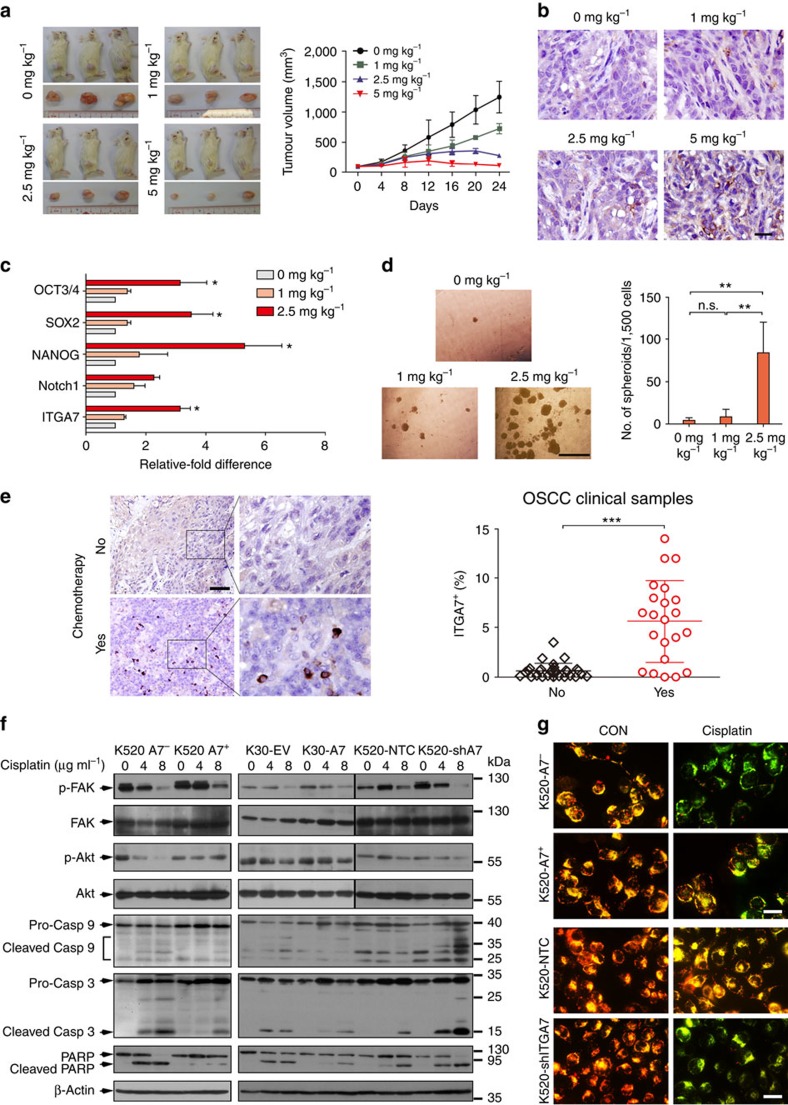
ITGA7 promotes chemoresistance via the FAK/Akt/Caspase-9/Caspase-3 pathway.(a) NOD/SCID mice with xenograft tumours of 5 mm in diameter were randomly separated into four groups and treated with varying doses of cisplatin. The doses of 2.5 and 5 mg kg−1 cisplatin could effectively suppress tumour growth and shrink tumour size. The average tumour volume was expressed as the mean±s.d. of three mice. (b) Representative IHC images showing that ITGA7+ cells were positively correlated with the dosage of cisplatin. Scale bar, 20 μm. (c) qRT-PCR showed that the expression of ITGA7 and stemness-associated genes was positively correlated with the dosage of cisplatin. (d) Representatives and summary of spheroid formation assay showing that isolated cells from chemoresistant group displayed enhanced self-renewal ability. Scale bar, 500 μm. (e) Representative images of ITGA7 IHC staining of clinical OSCC specimens had or had not undergone chemotherapy treatment. Compared with OSCC specimens without treatment (0.64%±0.74%; n=28), ITGA7+ cells were markedly increased after treatment (5.64%±4.15%; n=22). Scale bar, 100 μm. (f) Western blot analysis was used to detect indicated protein levels in given cells 24 h after cisplatin treatment. (g) Representative images of JC-1 dye staining 24 h after cisplatin (4 μg ml−1) treatment. JC-1 dye aggregates at high ΔΨm mitochondria (red) or forms monomers at low ΔΨm mitochondria (green). Scale bar, 50 μm. Statistics: (c,d) ANOVA with post hoc test. (e) Student t-test. *P<0.05; **P<0.001; ***P<0.0001; n.s., P≥0.05.